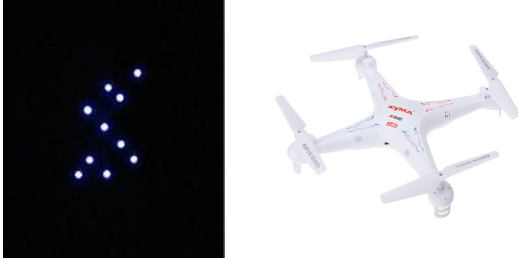
Figure 6. ( left ) 10 IR markers as captured by the web-camera with the IR filter. ( right ) A Syma X5C sensorless toy microquadcopter. Weight: ∼ 100 gr, cost: $30–$40.